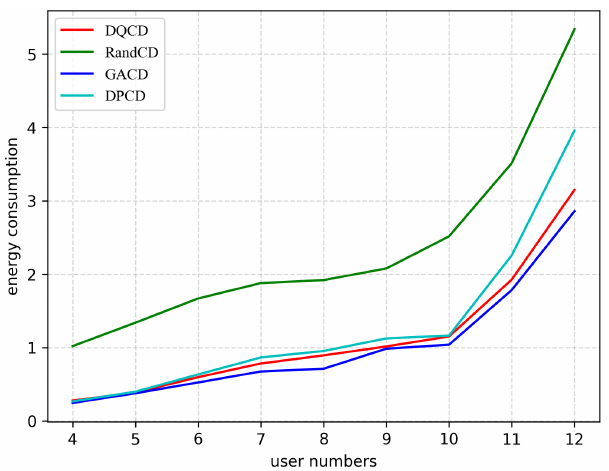
Figure 5. Comparison of execution